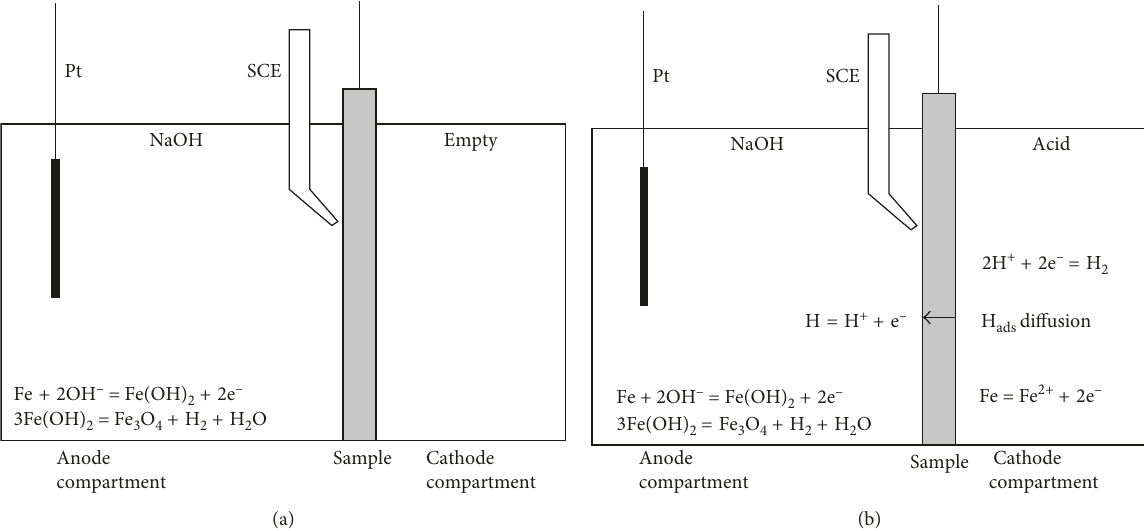
Figure 1: Schematic setup of the test cell with anodic and cathodic reactions at passivation and permeation test stages. Pt is platinum counterelectrode, and SCE is saturated calomel reference electrode. (a) During passivation. (b) During